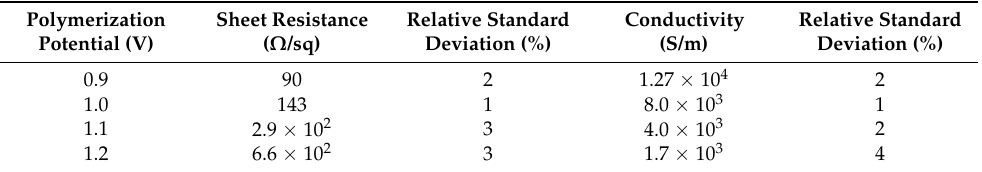
Table 4. Sheet resistance and conductivity of PPy films synthesized at different potentials and under control of electric charge (420 mC/cm 2